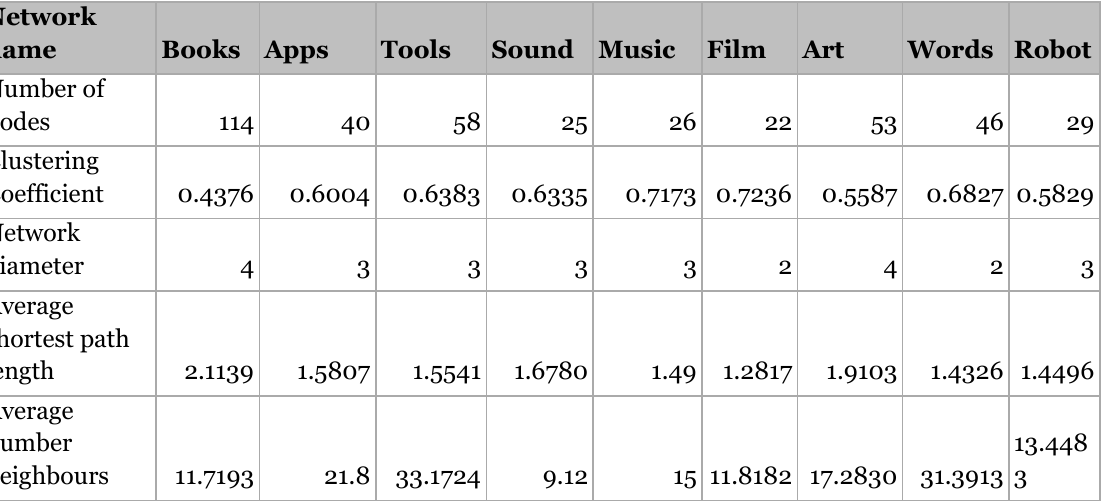
Network Properties in the Case of the Direct Relations (Conversations) Established Within Each Selected